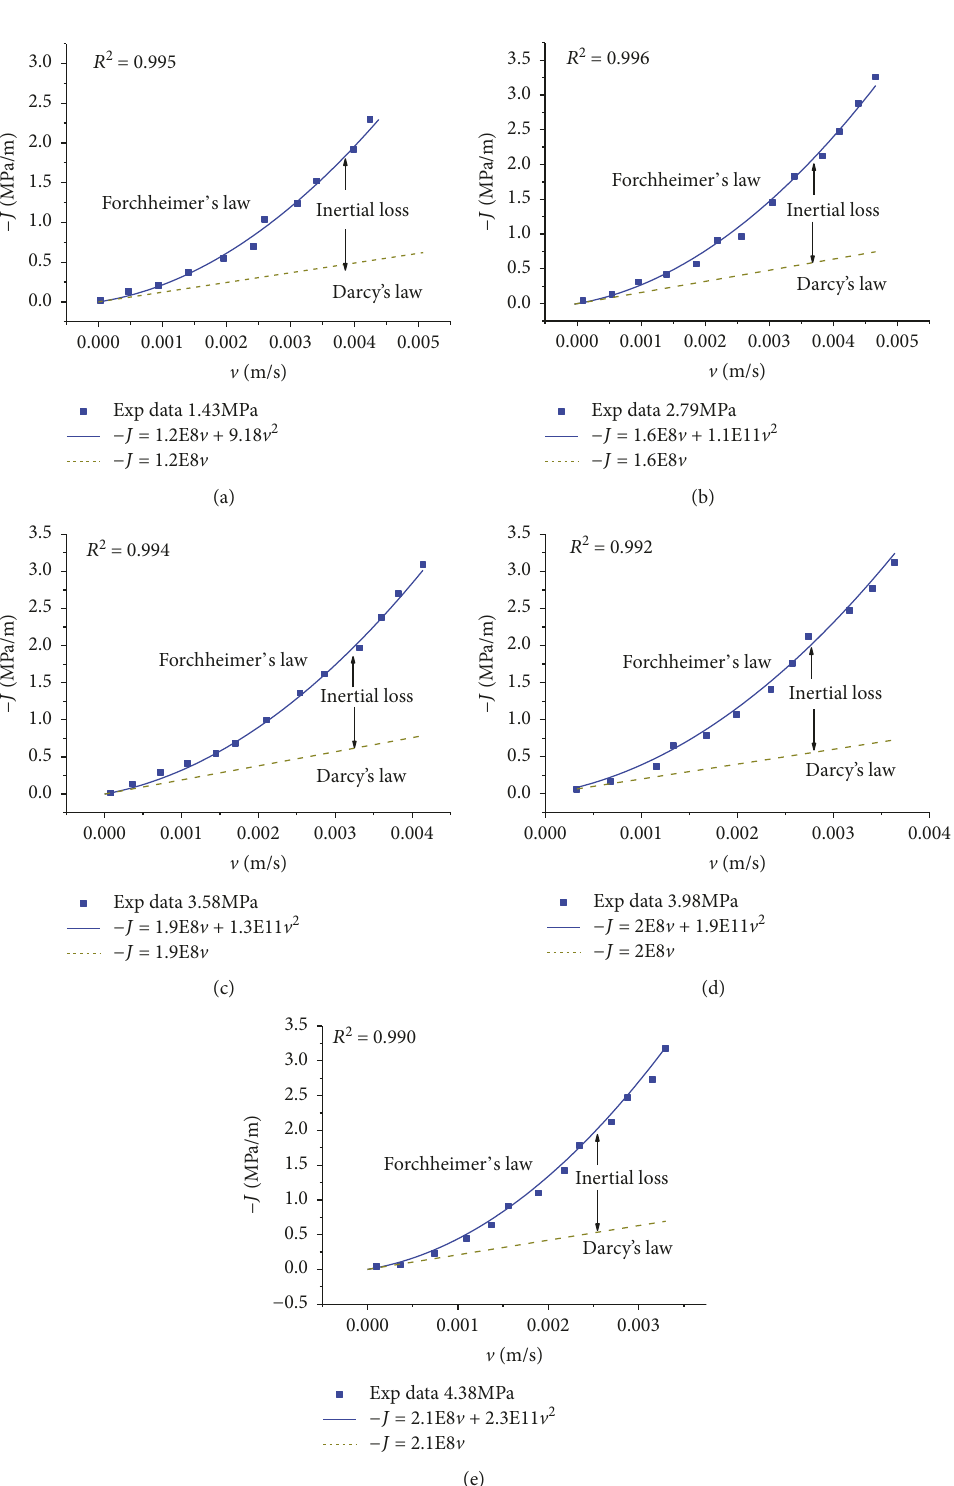
Figure 3: Characteristic of fl ow regime under di ff erent